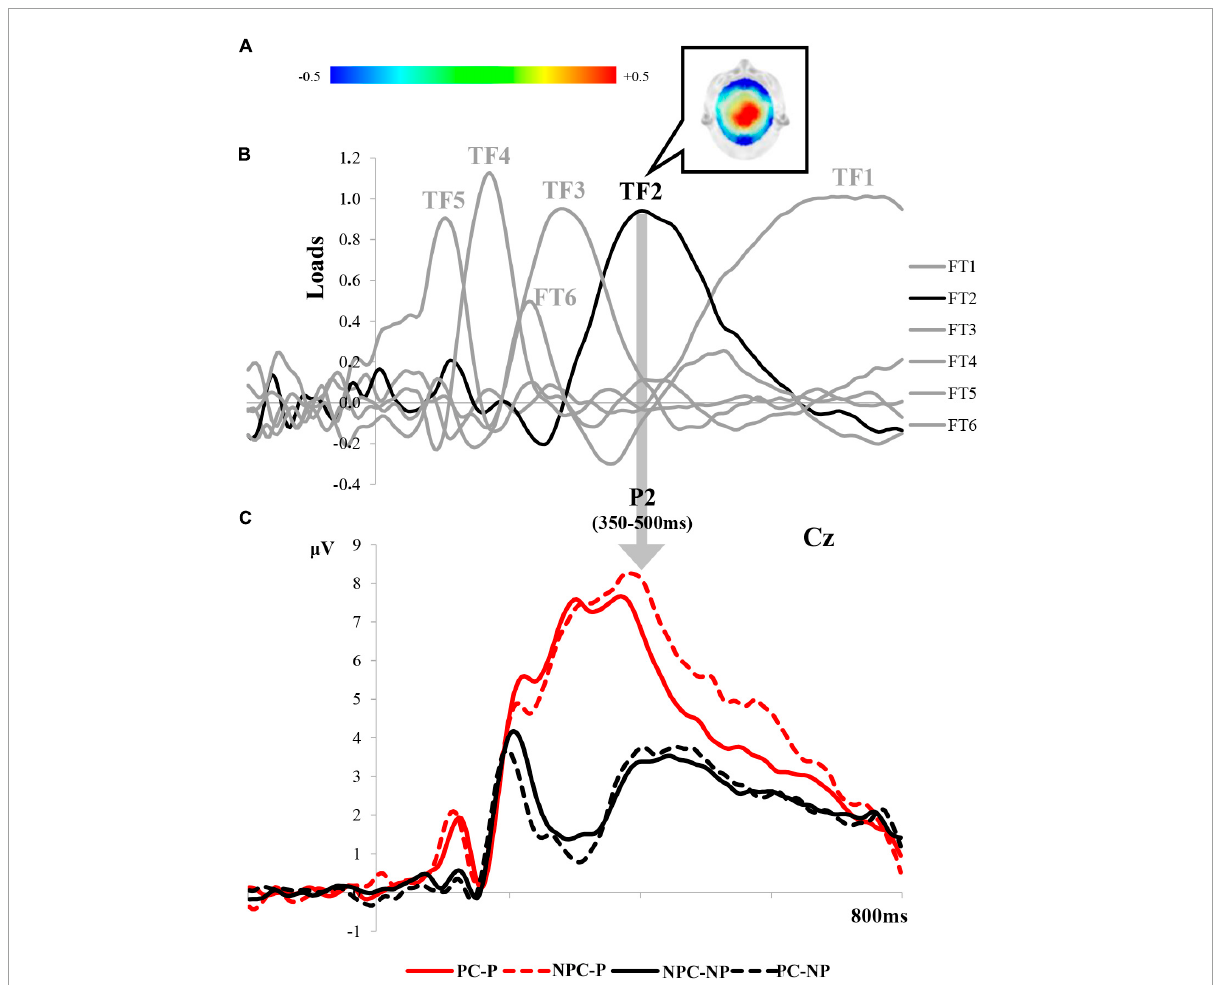
FIGURE4 Correspondence between TFs and ERP components derived from the tPCA in the pain-processing period: (A) topographical distribution of the P2 of the LEPs; (B) TF loads after the application of tPCA; and (C) correspondence of each component of the LEPs in the grand average of Cz. (PC-P, pain cue - pain; NPC-P, no pain cue - pain; NPC-NP, no pain cue - no pain; PC-NP, pain cue - no